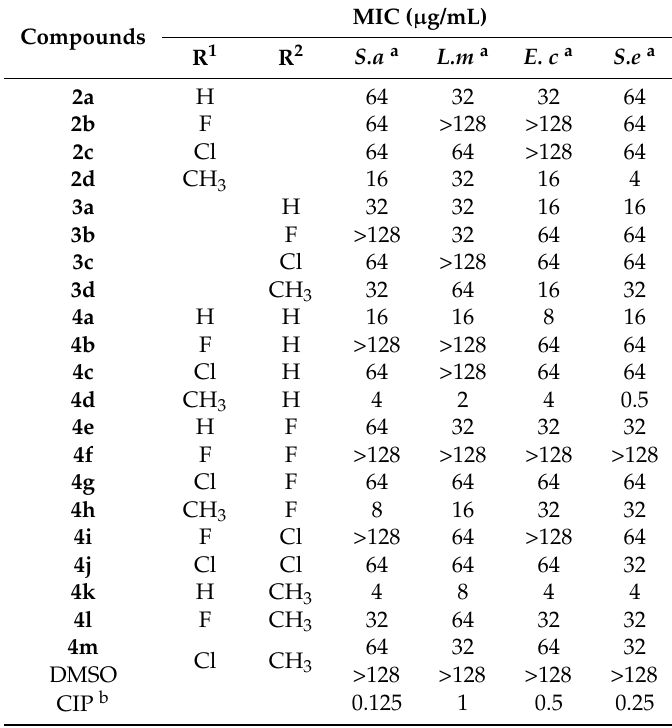
Table 1. Minimum inhibitory concentration (MIC) of all compounds against